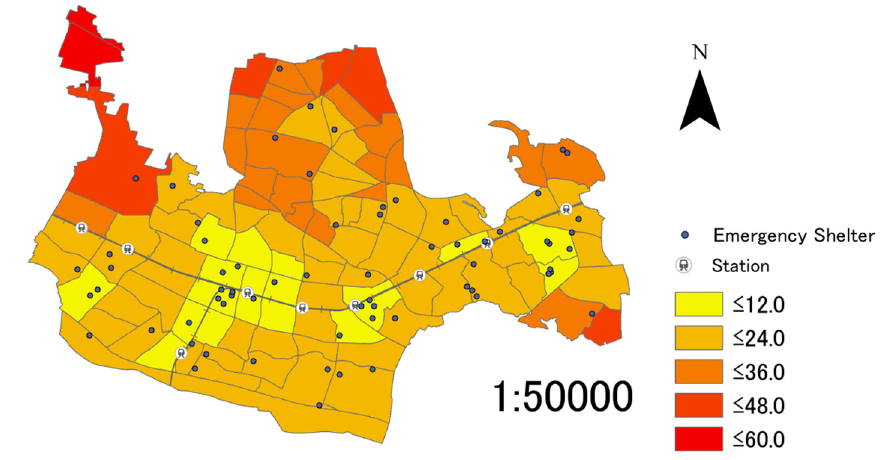
Figure 1. Result for Chofu City without a weighted coefficient.